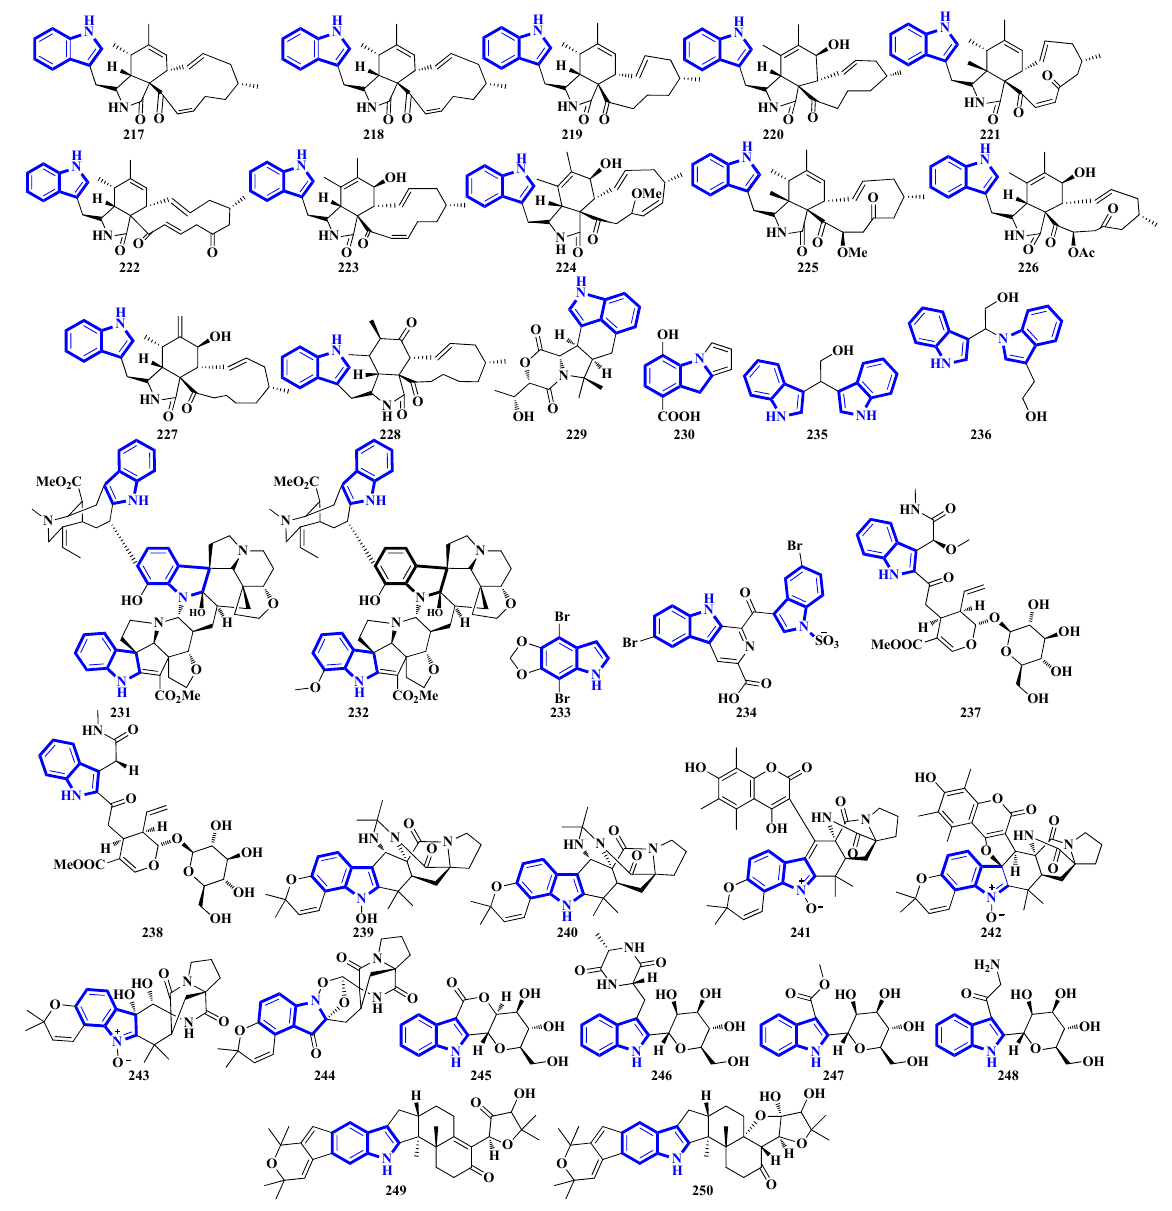
Figure 11. Novel indole alkaloids 217 to 250